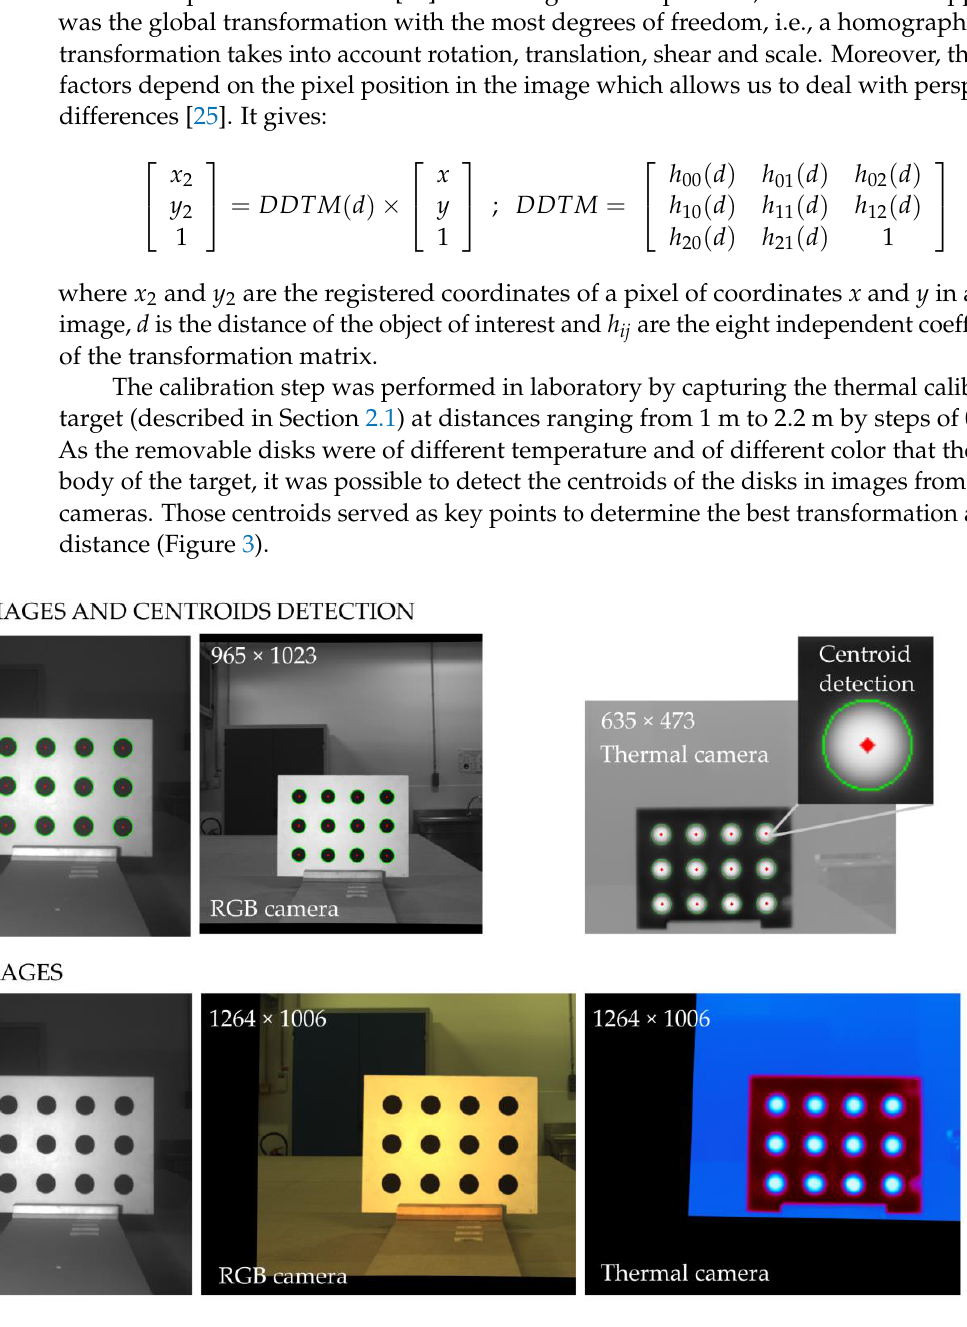
Figure 3. Registration of near infrared (NIR, 800 nm), red, green and blue (RGB) and thermal images of the calibration target. The 800 nm image is the master that is used as a reference to align the other images. For each camera, the values of the eight coefficients providing the best transfor- mations were related to the distance of the target using linear regressions. An example of such relation is given in Figure 4 for the DDTM that linked the thermal images to the master images. The same trend was observed for all the cameras. Only ℎ 02 and ℎ 12 sig- nificantly varied with distance. For the ℎ 02 regressions corresponding to the 490, 550, 680, 720, 900, RGB and thermal cameras, the determination coefficients (R 2 ) were respectively 0.00 (no change with distance), 0.85, 0.65, 0.86, 0.79, 0.01 and. 0.94. The root mean squared errors (RMSE) were, respectively, 5.2, 8.4, 7.1, 7.7, 4.8, 8.6 and 4.2 pixels. For the ℎ 12 re- gressions, R 2 were respectively 0.75, 0.03, 0.0, 0.84, 0.86, 0.81 and 0.90. The RMSE were respectively 5.9, 8.0, 8.1, 5.1, 4.5, 7.4 and 2.7 pixels. The other coefficients were approxi- mated to constants by considering the median of the measured values. ℎ 20 and ℎ 21 of all the matrices were close to 0, which is the case in an affine transformation matrix. This implies that the affine transformation model could have been used.